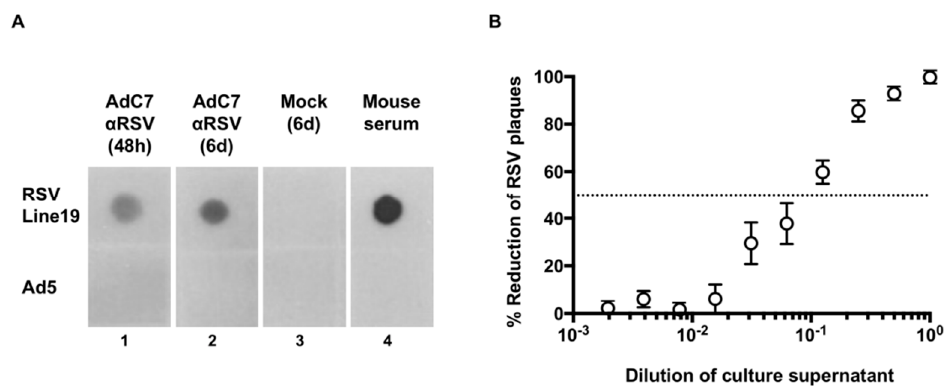
Figure 3. Assessment of anti-respiratory syncytial virus (anti-RSV) IgG expression in vitro. Supernatants of HEK-293 cells infected with AdC7 α RSV were assessed for the presence of functional anti-RSV IgG. ( A ) Binding to RSV. Supernatants were incubated with RSV Line19 or Ad5 (control) immobilized on a polyvinylidene difluoride (PVDF) membrane followed by an HRP-conjugated sheep anti-mouse IgG. Mouse serum 8 weeks post infection with RSV was used as a positive control (lane 4). ( B ) Plaque-reduction assay. Serial dilutions of supernatants were incubated with RSV Line19 (5x10 3 pfu/ml) for 1 hour, followed by infection of Vero cells. Data are shown as % reduction of plaques after 4 days, with mean ± SEM of 4 replicates.